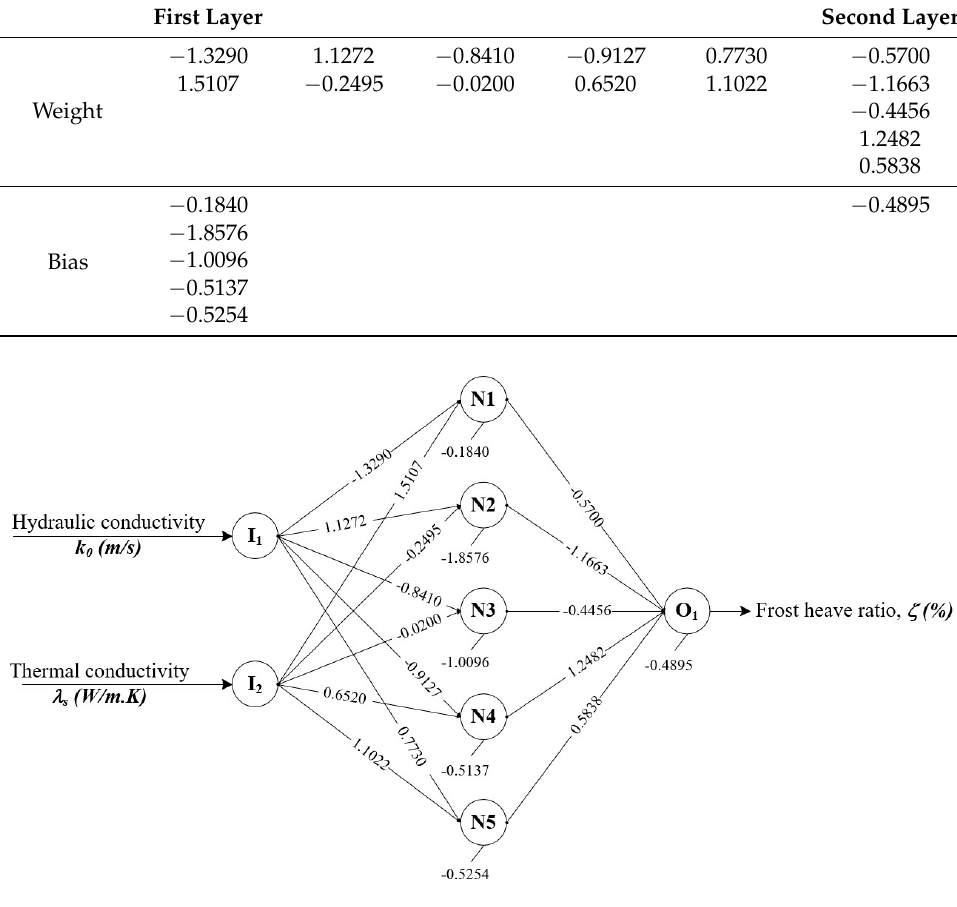
Figure 11. Weights and Biases of the ANN network.